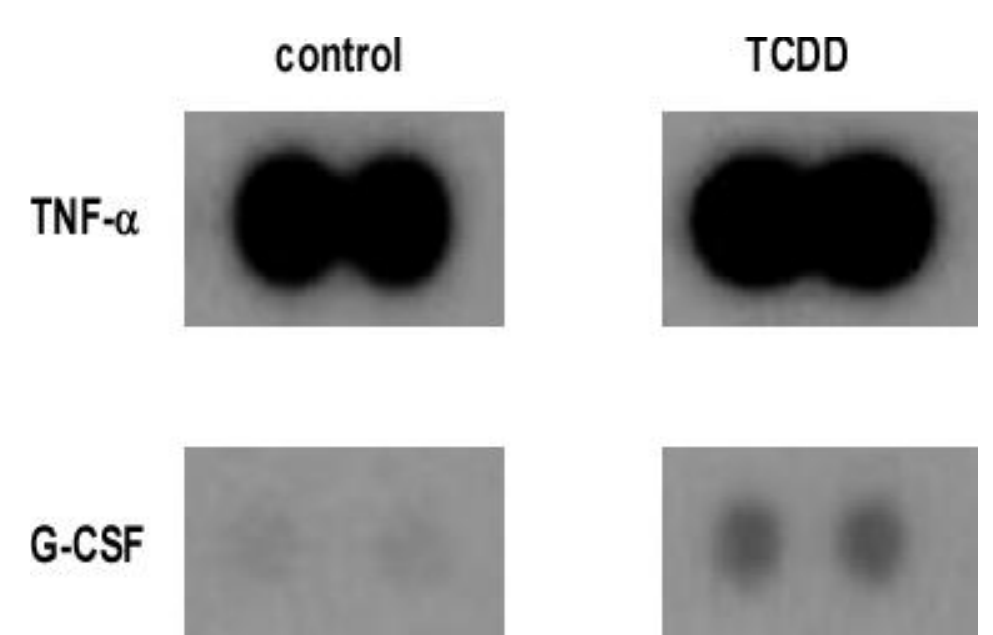
Figure 1. Chemokine-Cytokine screening. Activation of AhR in macrophage induced inflammatory markers and fibrosis-associated genes. RAW 264.7 cells were nursed in serum-free DMEM media with TCDD (10 −8 M) for 24 h. The cytokine/chemokine expression profiles in RAW 264.7 cells induced by TCDD were analyzed and compared to control cells that were treated with DMSO.